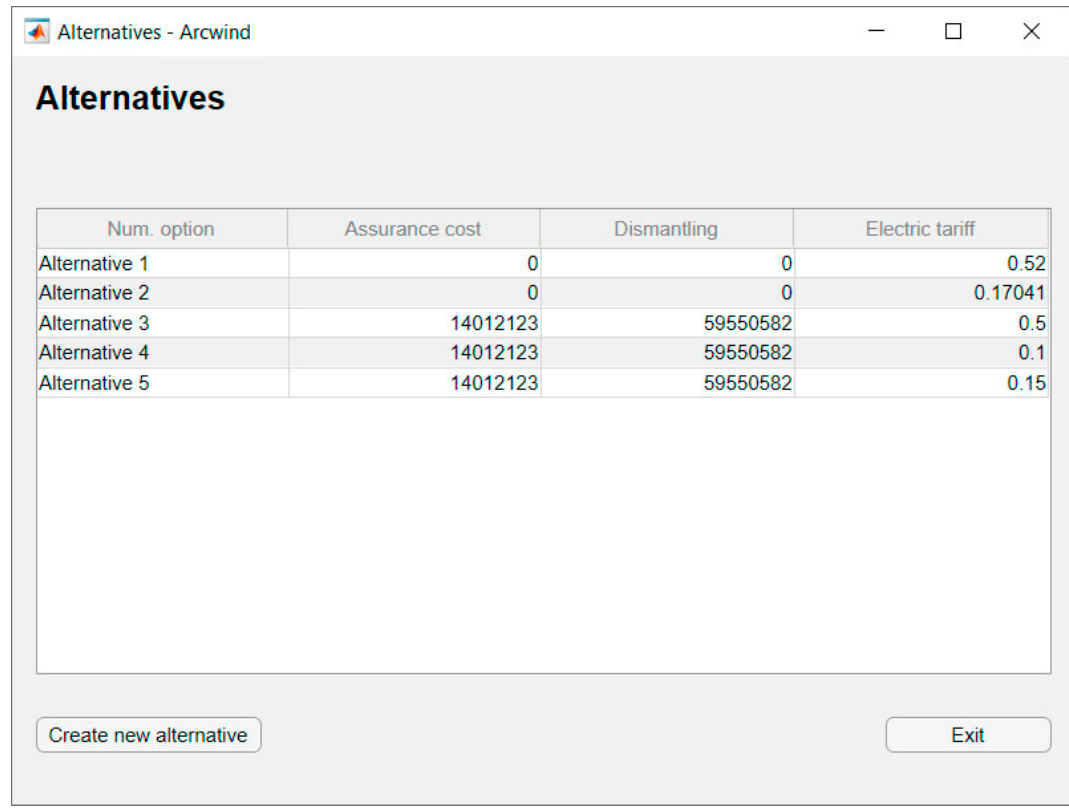
Figure 4. Alternatives window.